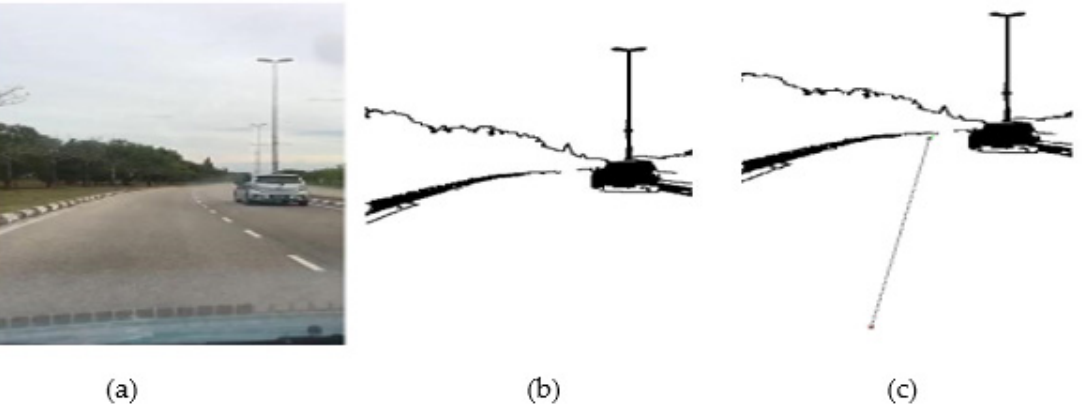
Figure 16. GLS with obstacles in the road. ( a ) Original image; ( b ) image from pre-processing; ( c ) applying GLS algorithm (dash line).